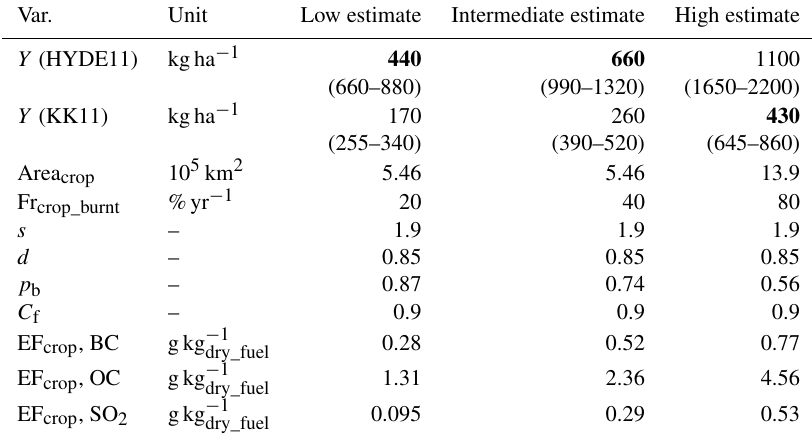
Table 2. The values needed to calculate the aerosol emissions from crop residue burning (Eq. 5) for the low, intermediate, and high scenarios. The total area of crop in the study domain (Area crop ) is shown instead of the fraction per grid box (Fr crop ). The bold values for Y show which values were taken for the calculation, and the values in brackets represent the yields considering